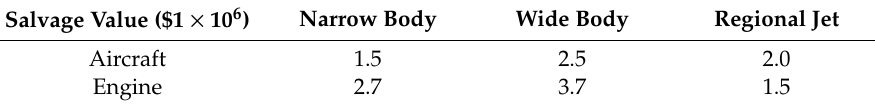
Table 3. Average salvage value of parts from an aircraft / engine (2014 USD) [2].